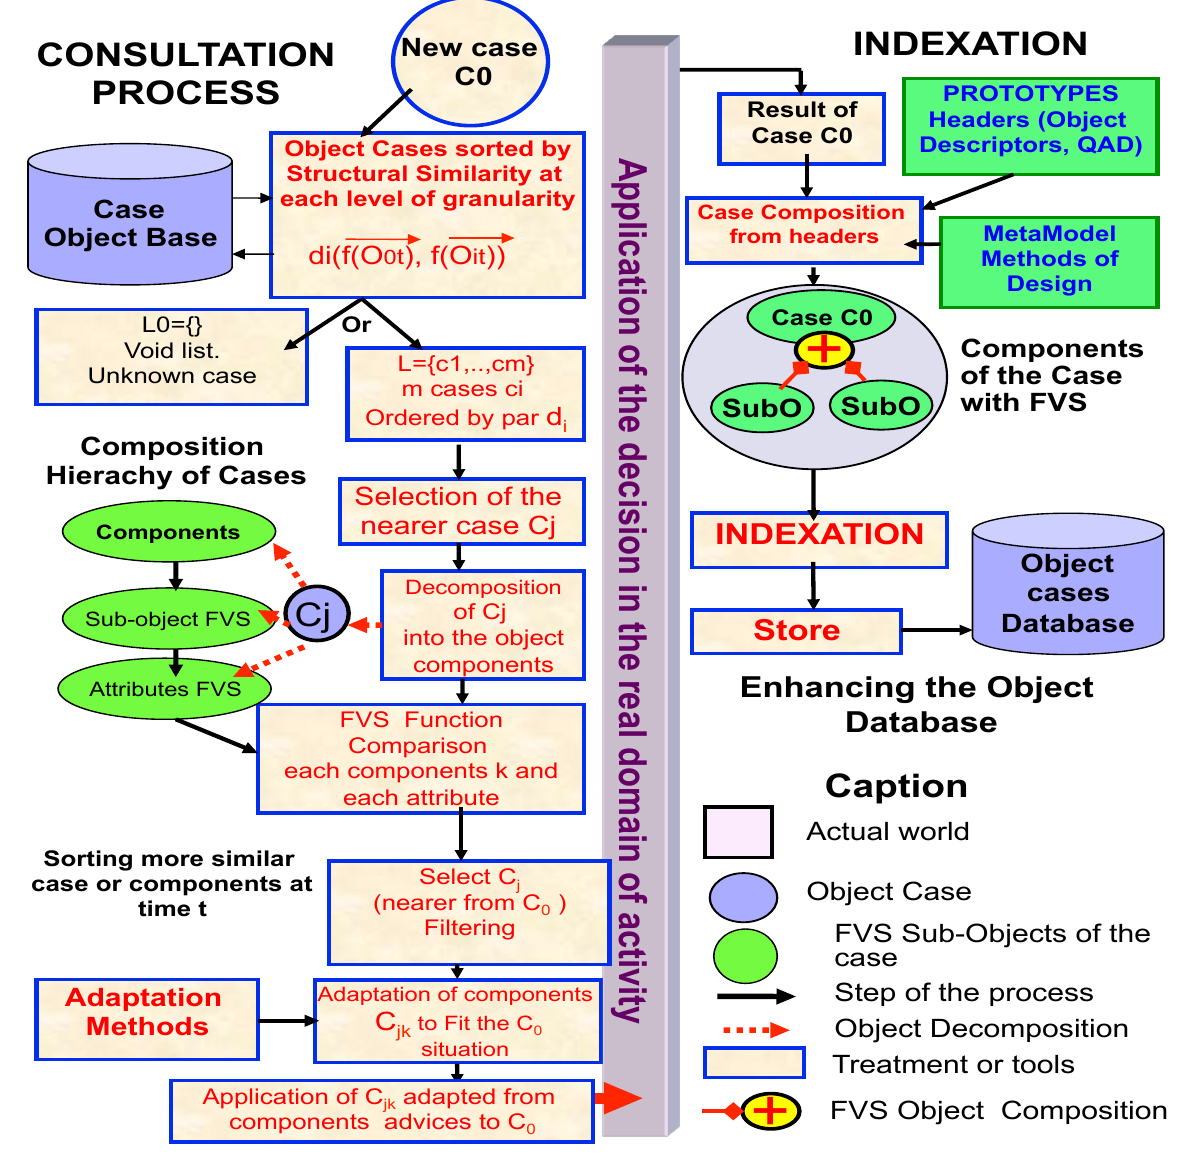
Figure 11. A case-based reasoning cycle extended from